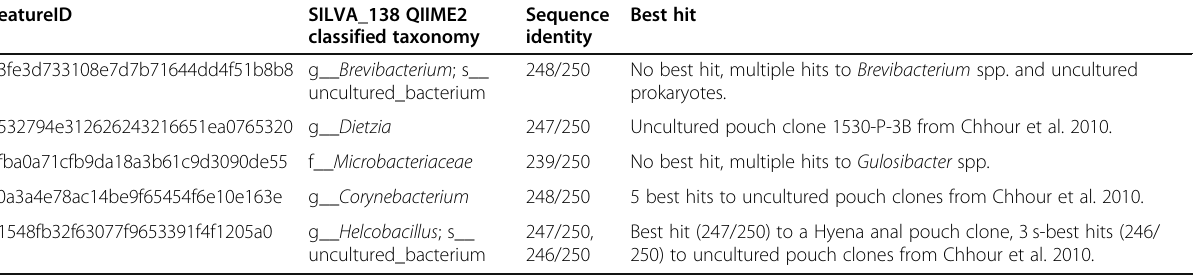
Table 1 | BLAST results from the top five most abundant features in the cycling/lactating pouch, joey, and milk samples. Two features have best hits, and one feature has multiple second-best hits to bacterial 16S clones isolated from Tammar wallaby